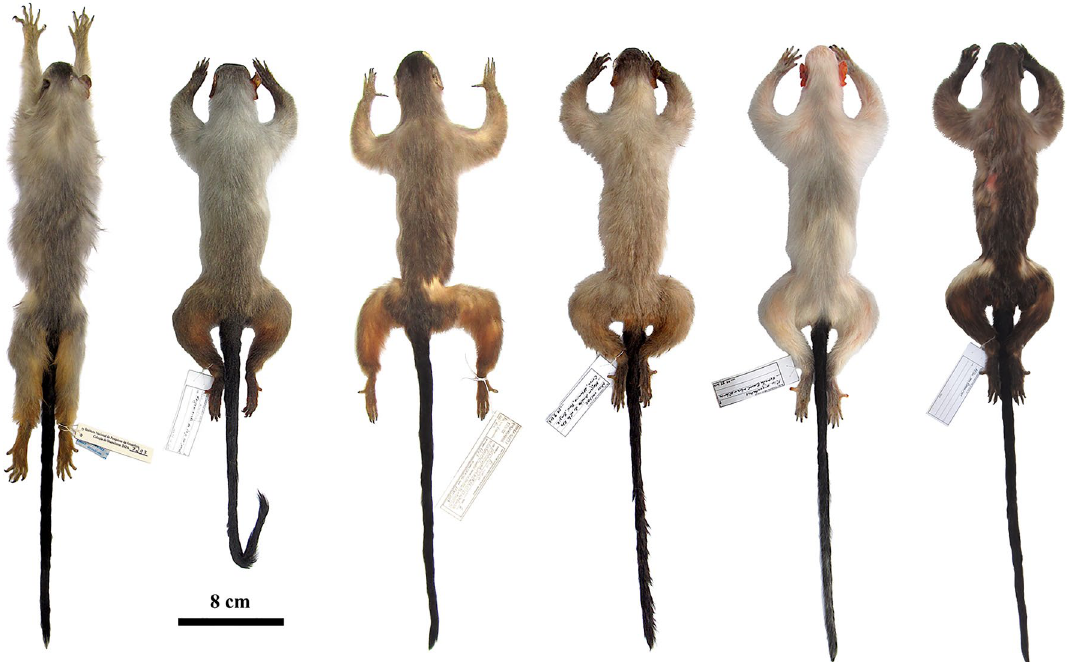
Figure 3. Dorsal view of skins of Mico species tested for diagnosability of morphological characters of pelage colour. Left to right: Mico schneideri sp. n. holotype (INPA 7293), M. rondoni (MPEG 45620), M. marcai (MPEG 42807), M. emiliae (MPEG 45566), M. argentatus (MPEG 45609), and M. melanurus (MPEG